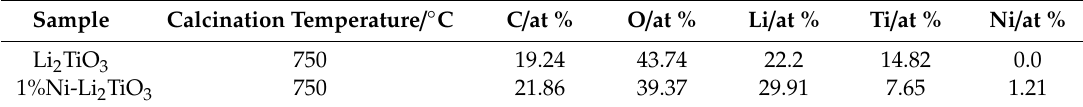
Table 5. The relative atomic concentrations of C, O, Li, Ti and Ni before and after Ni doping.